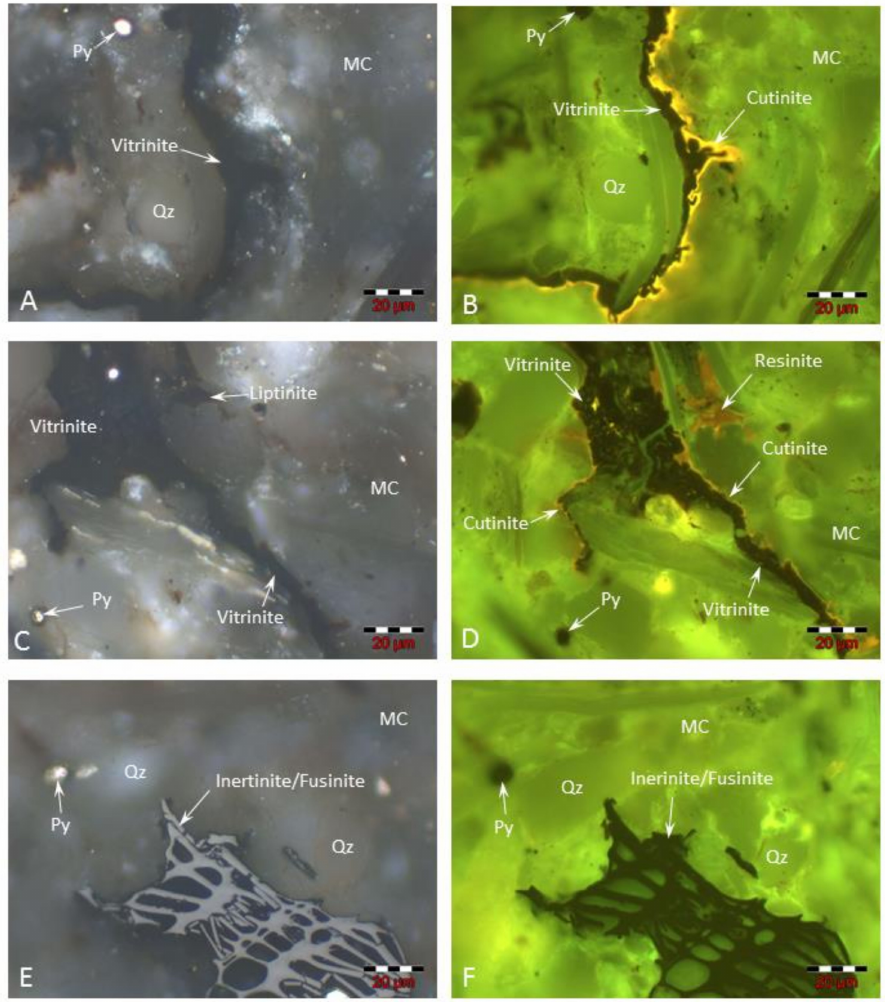
Figure 7. Photomicrographs of A-1 Hurezani Upper Badenian source rocks of the Getic Depression showing the continental origins of macerals in a mineral carbonate (MC) groundmass with quartz (Qz), and pyrite (Py). Reflected light (RL: figures A , C , E ) and fluorescent light (FL: figures B , D , F ), oil immersion, 500 ×